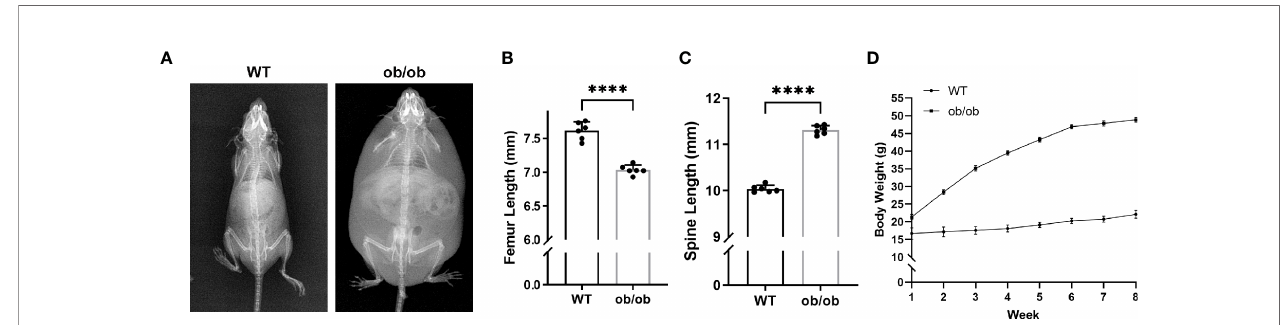
FIGURE 1 | Comparison of body length between wild-type (WT) mice and ob/ob mice at the end of 8 weeks. (A) X-ray plain fi lm of WT and ob/ob mice. (B) Femur length. (C) Spine length. (D) Body weight. Values are means ± SD. n = 6, **** p <